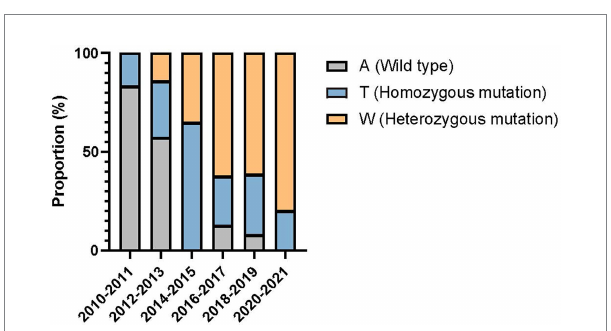
FIGURE 3 Temporal shift in the composition of single nucleotide polymorphisms at position 395 of ERG11 gene in 86 fluconazole- resistant